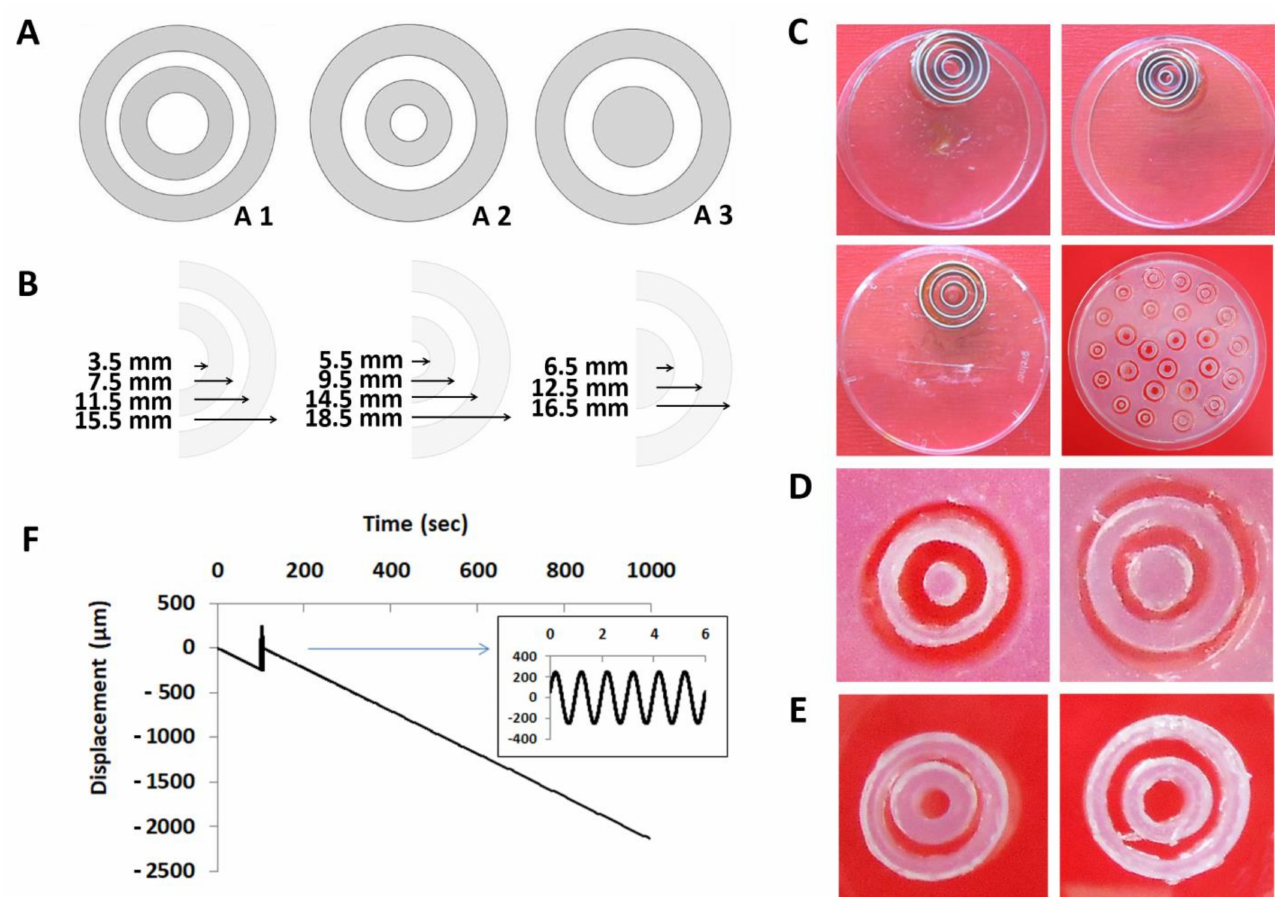
Figure 1. Architectural design variations, fabrication, and mechanical characterization of load-sharing, two-component composite model systems . ( A ) Illustration of the three architectural designs A1, A2, and A3. Dark gray illustrates elements fabricated from stiffer biomaterials, namely 5% agarose or caffeic acid-crosslinked gelatin. White illustrates elements fabricated from the softer biomaterial, 0.5% agarose. ( B ) Diameters of the central elements and inner and outer diameters of the central element-surrounding rings. The central element diameters were 3.5 mm and 5.5 mm of architectures 1 and 2 (for a